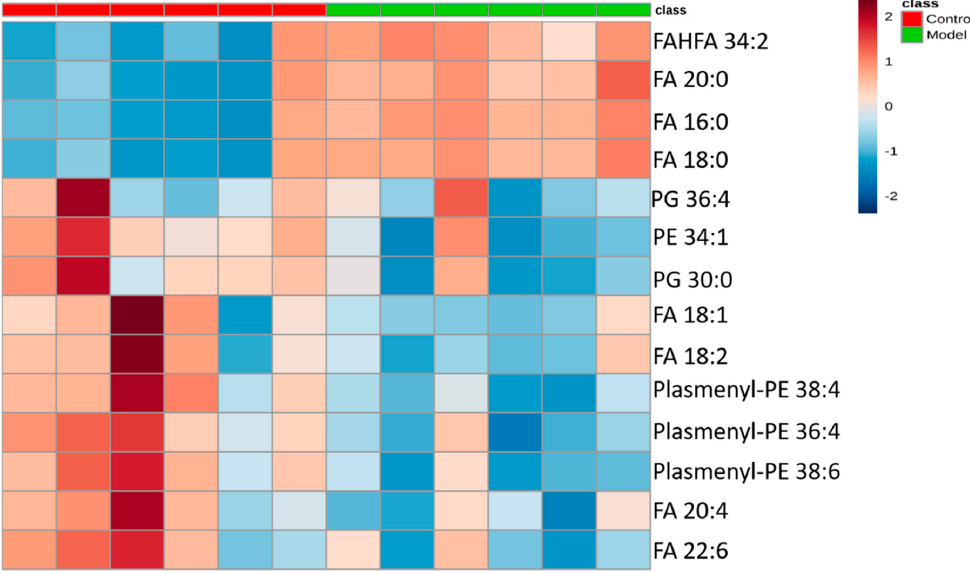
Figure 8. Heatmap of identified di ff erential lipids in BALF (negative ion mode). Each square in the heatmap represents the corresponding intensity value of a phospholipid of samples in each group, red represents the increase in concentration and blue represents the decrease in concentration.